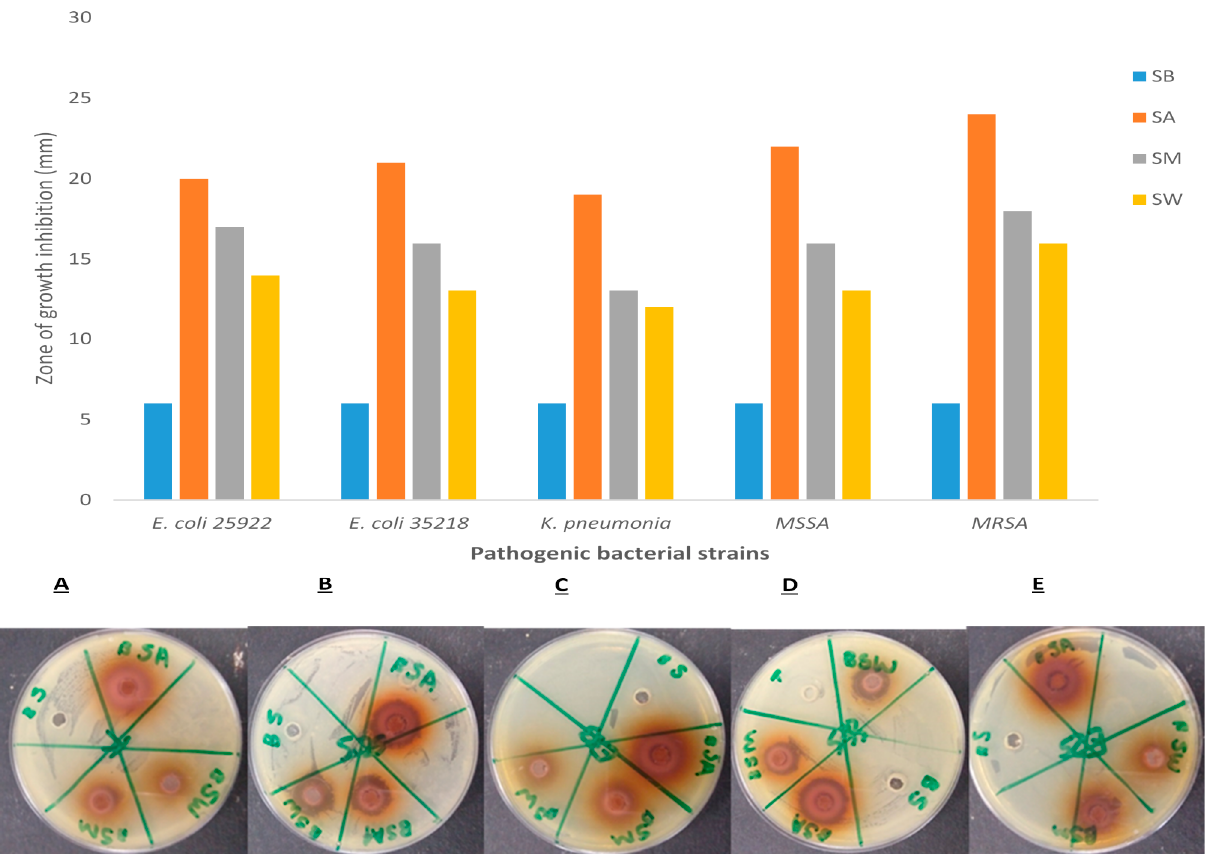
Figure 5. Antibacterial activity of P. grandiflora tuber extracts conjugated with biologically synthesized silver nanoparticles against selected bacterial strains; E. coli 25,922 ( A ), E. coli 35,218 ( B ), K. pneumonia ( C ), Methicillin-susceptible Staphylococcus aureus (MSSA) ( D ), Methicillin-resistant Staphylococcus aureus (MRSA) ( E ). where SB (Biologically synthesized silver nanoparticles), SA (Silver nanoparticles and acetone extract), SM (Silver nanoparticles and methanol extract), SW (Silver nanoparticles and water extract).